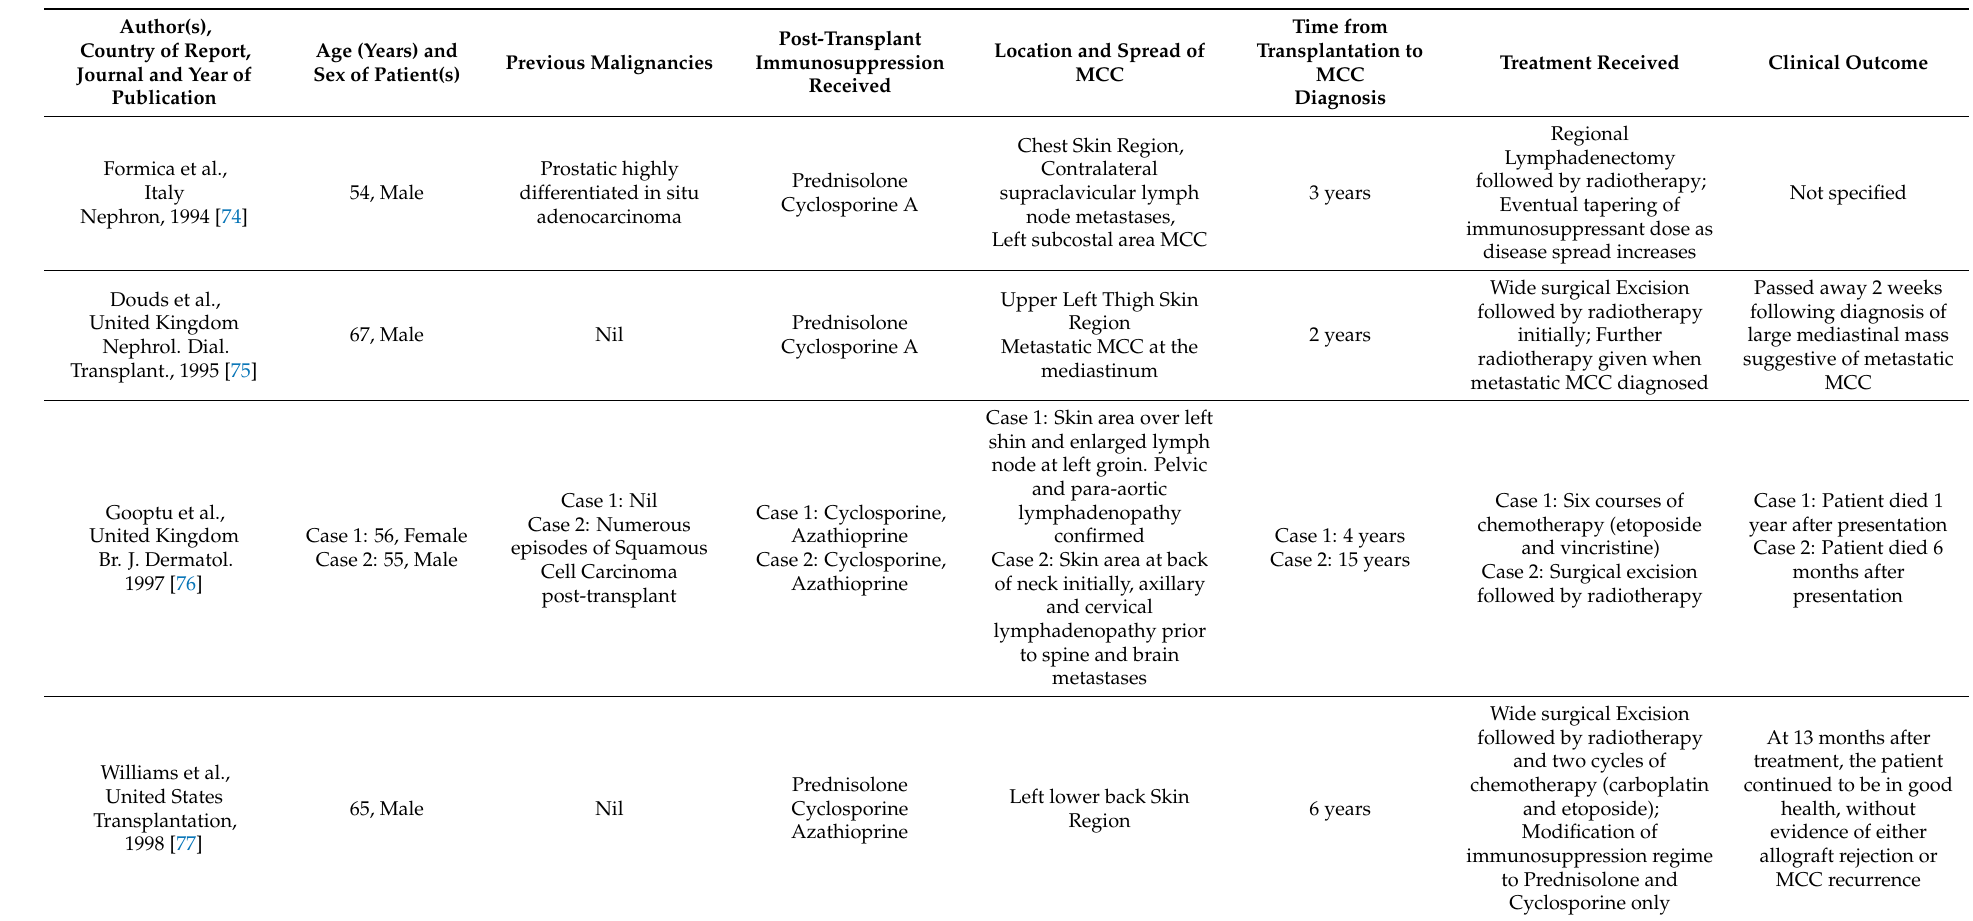
Table 1. Case Reports and Case Series of MCC in Kidney Transplant